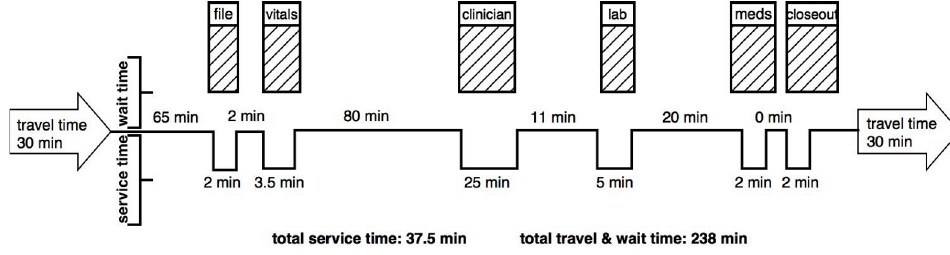
Fig 1. Value stream map of median wait and service times for 15 clinic visits among recently hospitalized people living with HIV in South Africa (not to scale).